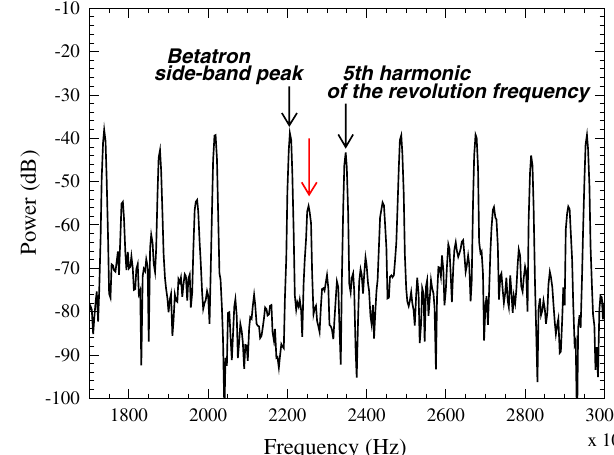
FIG. 16. (Color) FFT spectrum for horizontal BPM data taken for 0.16 ms time span with 6.4 MHz sampling in the middle of the injection process. As for the red arrow, see the text.